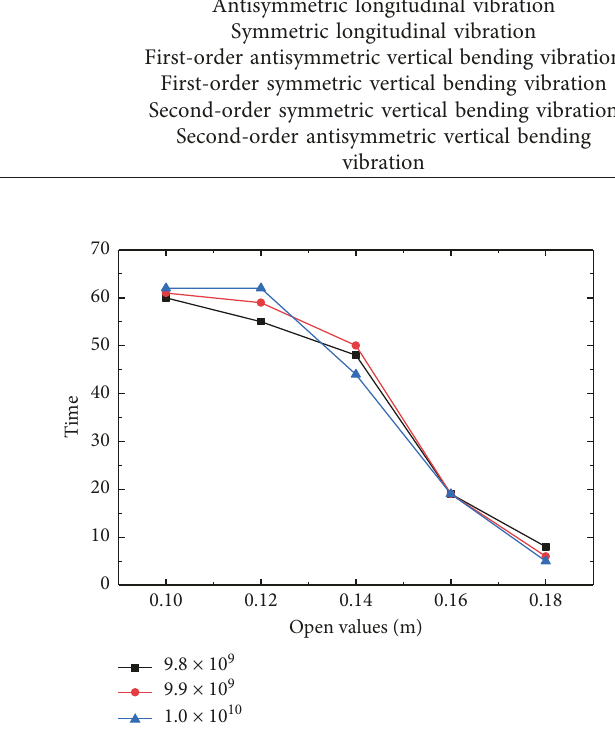
Figure 4: Number of